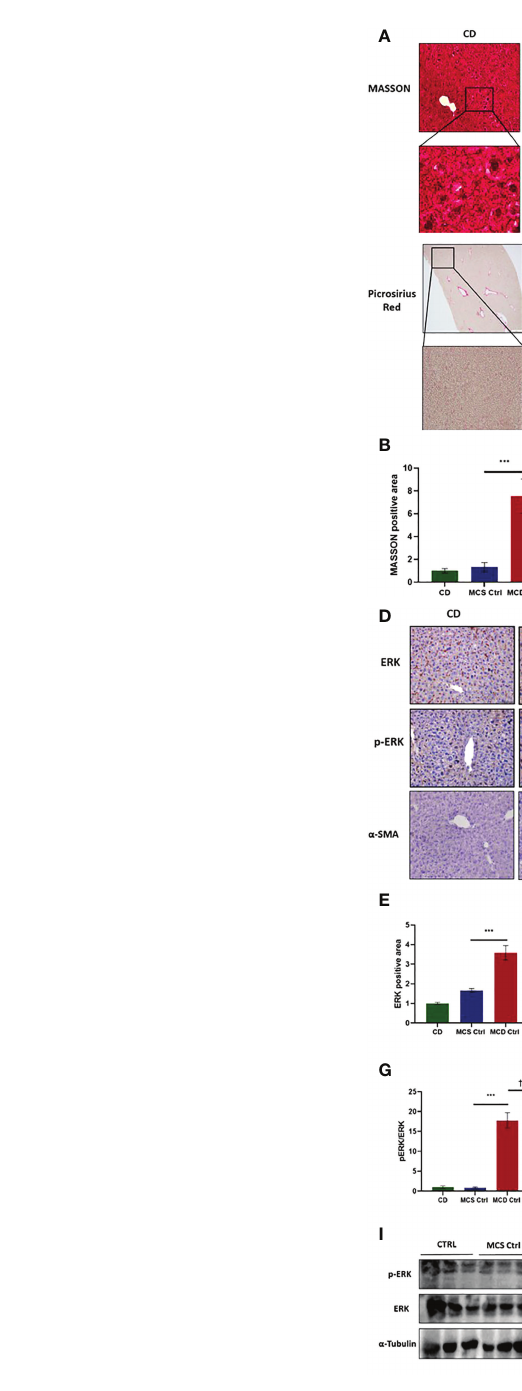
FIGURE 5 Theabrownin reduces hepatic fi brosis in MCD diet-fed mice. (A) Liver section for Masson and Picrosirius Red staining. (B, C) Quanti fi cation of positive area for Masson and Picrosirius Red staining. (D) IHC for ERK, ERK phosphorylation, and a -SMA. (E) Quanti fi cation of IHC positive area for ERK. (F) Quanti fi cation of IHC positive area for ERK phosphorylation. (G) Quanti fi cation of ERK phosphorylation from IHC (normalized by total ERK). (H) Quanti fi cation of positive area for a -SMA. (I) Protein levels of ERK and ERK phosphorylation. (J) Quanti fi cation of ERK phosphorylation from western blot. AU, arbitrary units. n=5-11 mice per group. The data are mean ± s.e. (error bars). ***p < 0.001, MCS Ctrl vs. MCD Ctrl. † , p<0.05, †† , p<0.01, ††† , p<0.001 MCD Ctrl vs. MCD